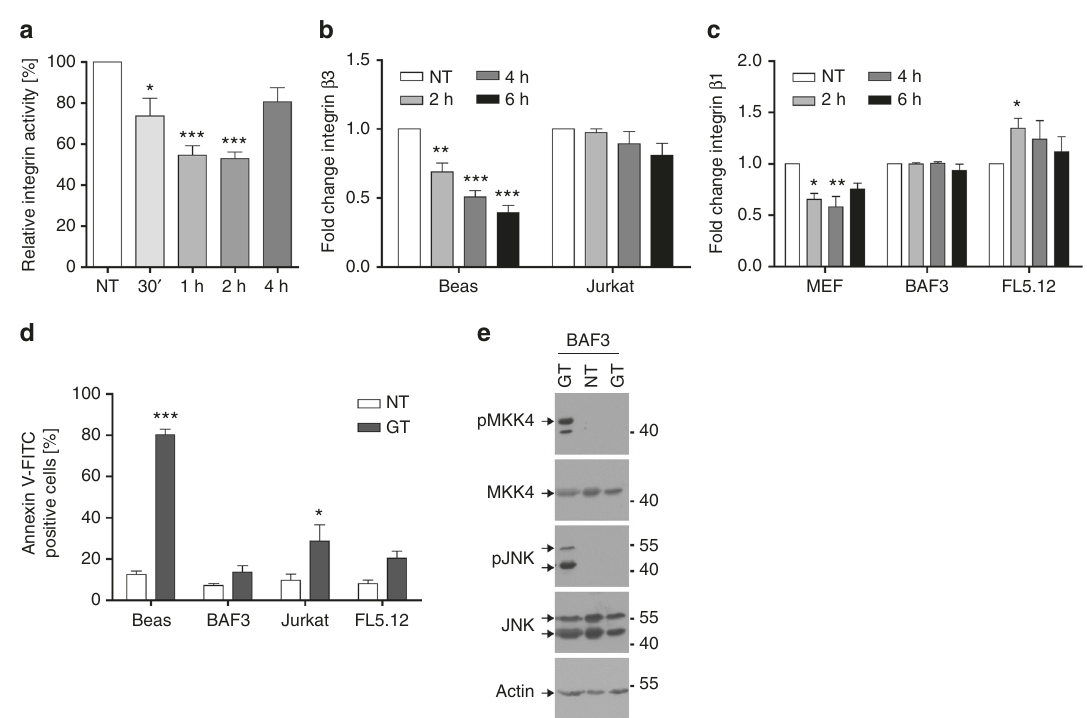
Fig. 6 GT diminishes RGD binding and surface expression of integrins. a The binding capacity of integrins to extracellular matrix components was measured on untreated (NT) and GT-treated BEAS-2B cells by FACS analysis of RGD-FAM peptide staining. b , c Adherent human lung epithelial cells (BEAS-2B) or MEFs showed reduced surface expression of integrin β 3 ( b ) or integrin β 1 ( c ), respectively, after 2 – 6 h of GT treatment as evidenced by FACS analysis of anti-integrin-stained cells. Human Jurkat ( b ) or mouse BAF or FL5.12 suspension cells ( c ) did not show such a reduction although they expressed integrins on their surface (Supplementary Fig. 7A and 7B), most likely in an inactive form (Supplementary Fig. 7C). d While BEAS-2B cells underwent apoptosis (as determined by annexin V-FITC FACS analysis) after 1 µ M GT treatment for 6 h, this was not the case for BAF3, Jurkat or FL5.12 suspension cells. e Western blot analysis of total extracts of BEAS-2B cells ( fi rst lane) or BAF3 cells either untreated (NT) or treated with 1 µ M GT for 6 h showing that GT did not cause phosphorylation/activation of MKK4 and JNK in BAF3 but does so in BEAS-2B cells. Actin was used a loading control. Graphs in a – d show the means of at least three independent experiments ± s.e.m.; p -values: *0.05 – 0.01, **0.01 – 0.001, ***<0.001,